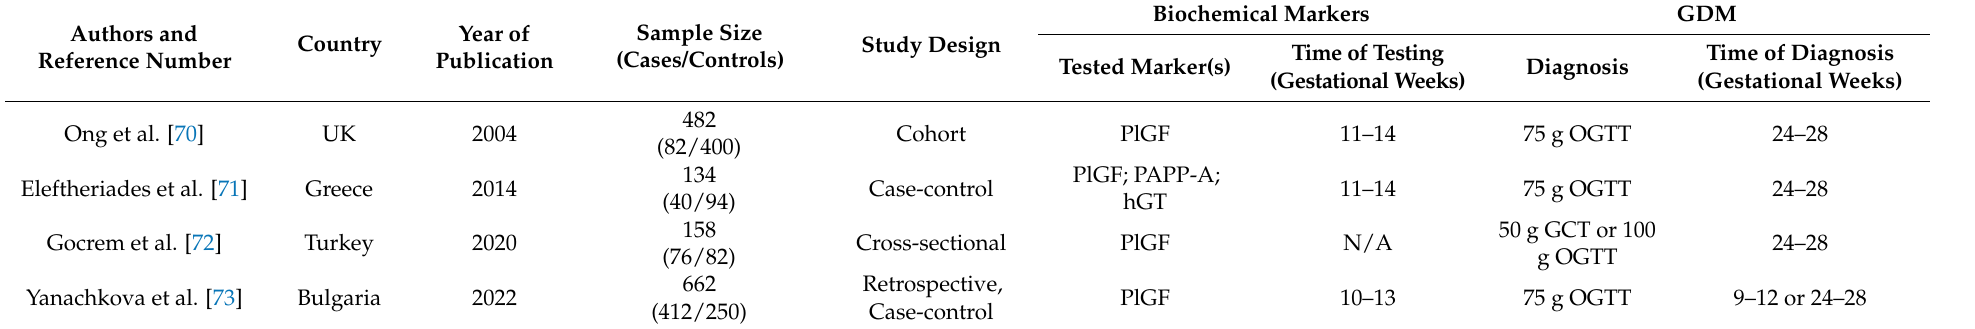
Table 2. Studies establishing a significant relationship between elevated serum PlGF levels and